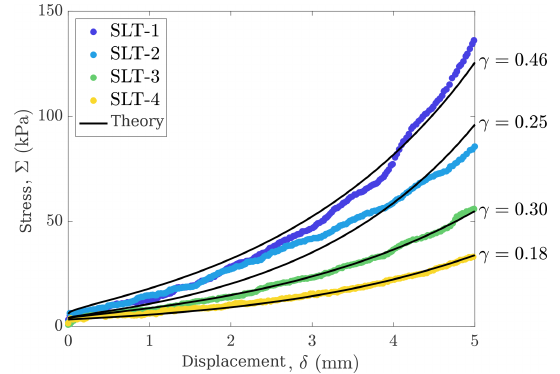
Figure 4. Comparison of theory with French-press experiments from Wang and Baker (2013): four snow samples were compacted in a Skyscan micro CT scanner at a constant displacement rate (see Sect. 2 and Fig. 1). Using the theory outlined in Sect. 3, the starting density of each sample, and reasonable parameters, we show agree- ment between theory and experimental data. For the theory, the constitutive exponents are the typical values ( a = 3, b = 2, m = 2, n = 2), the stress was scaled (i.e., prefactor N 0 = 30kPa, friction σ f = 3kPa), and the values of γ for each curve are shown on the